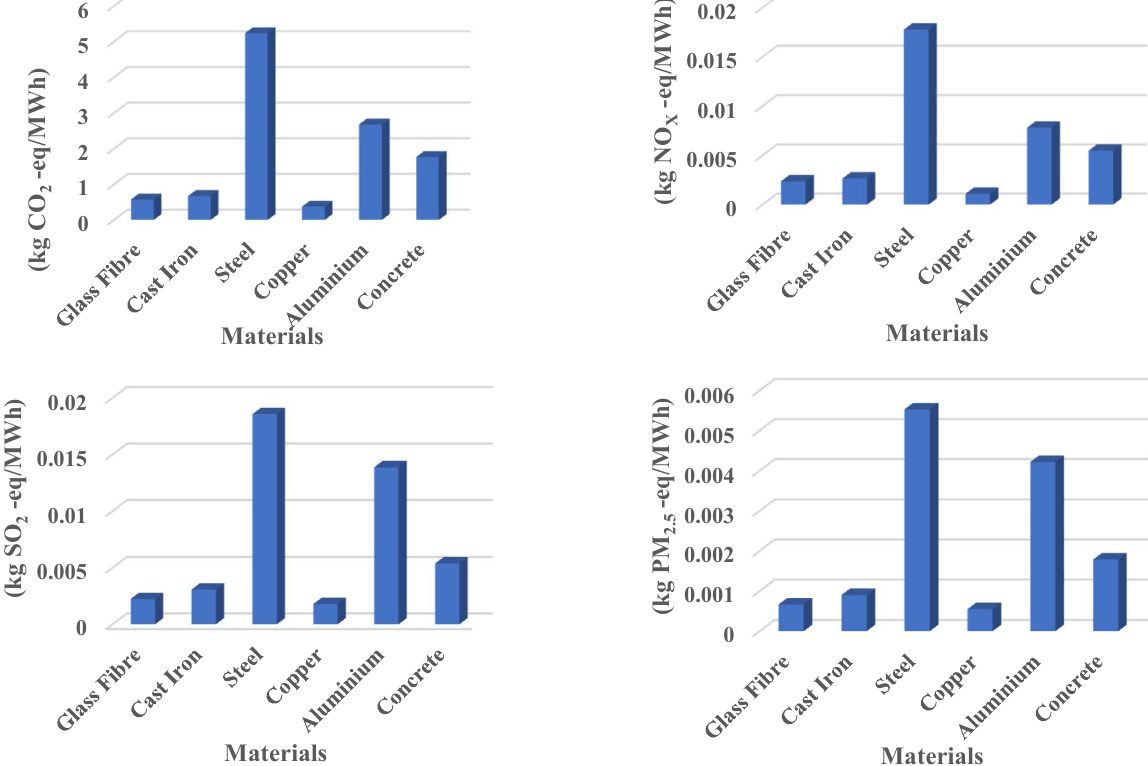
Figure 6. Life cycle emissions from different materials used in wind turbine production. NO x can cause photochemical ozone formation, which affects the plants by dam- aging the photosynthesis process and human health, causing issues such as irritation in the eyes, and respiratory system and dental problems. The figure for total NO x emis- sions is 0.037 kg-eq./MWh. During the life cycle phase of a wind farm, steel makes the largest contribution in environmental impact (0.017 kg NO x -eq/MWh) followed by alu- minium (0.008 kg NO x -eq/MWh) and concrete (0.005 kg NO x -eq/MWh). These three materials contribute 83.5% of total NO x emissions. Total SO 2 emissions are estimated to be 0.045 kg-eq./MWh. SO 2 is categorized as acidification potential, which is a pioneer of acid rain affecting ecosystem, soil and water bodies. The major contributor of SO 2 emissions is steel (0.018 kg/MWh), followed by aluminium (0.013 kg SO 2 -eq/MWh) and concrete (0.005 kg SO 2 -eq/MWh). These three materials contribute 84.1% of total SO 2 emissions. Emissions of particulate matter PM 2.5 total 0.013 kg-eq./MWh from a wind farm. Steel with proper maintenance. has a higher contribution to PM 2.5 than other materials. Steel, aluminium and concrete contribute 84.5% of total PM 2.5